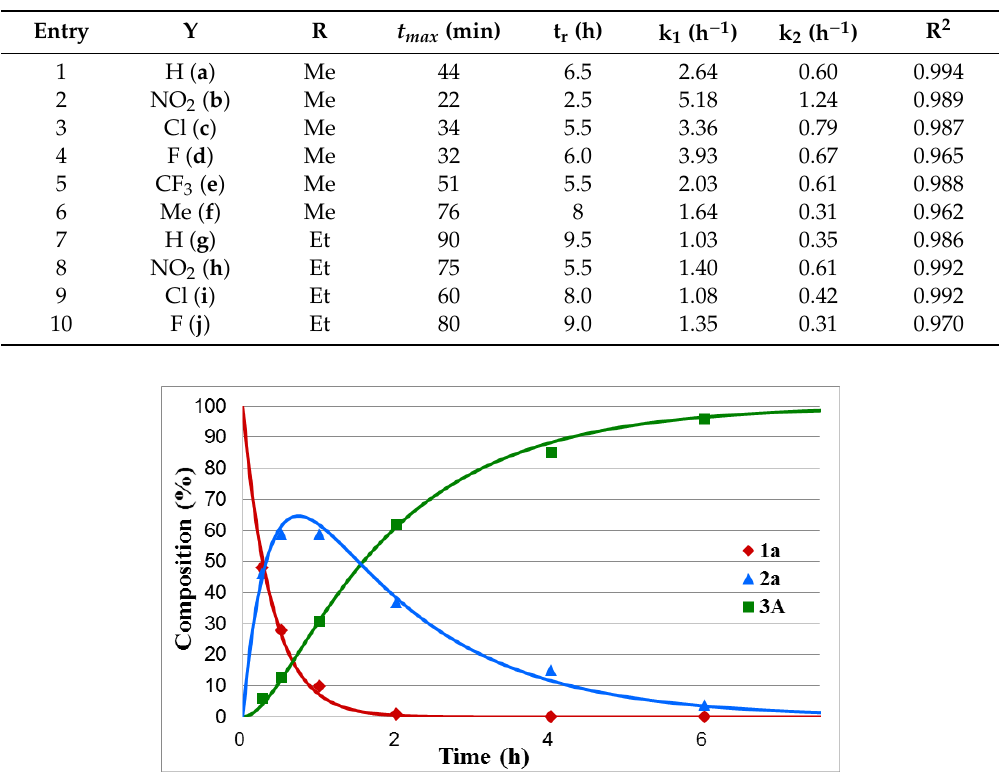
Figure 2. Concentration profile for the components during the hydrolysis of diethyl α-hydroxybenzylphosphonate ( 1g ) under optimum conditions. The R 2 measure of goodness of fit is 0.986.